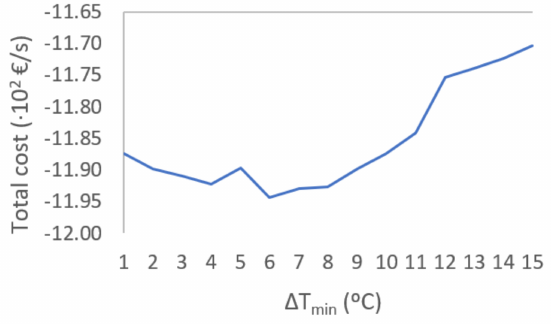
Figure 7. Selection of ∆ T min in heat